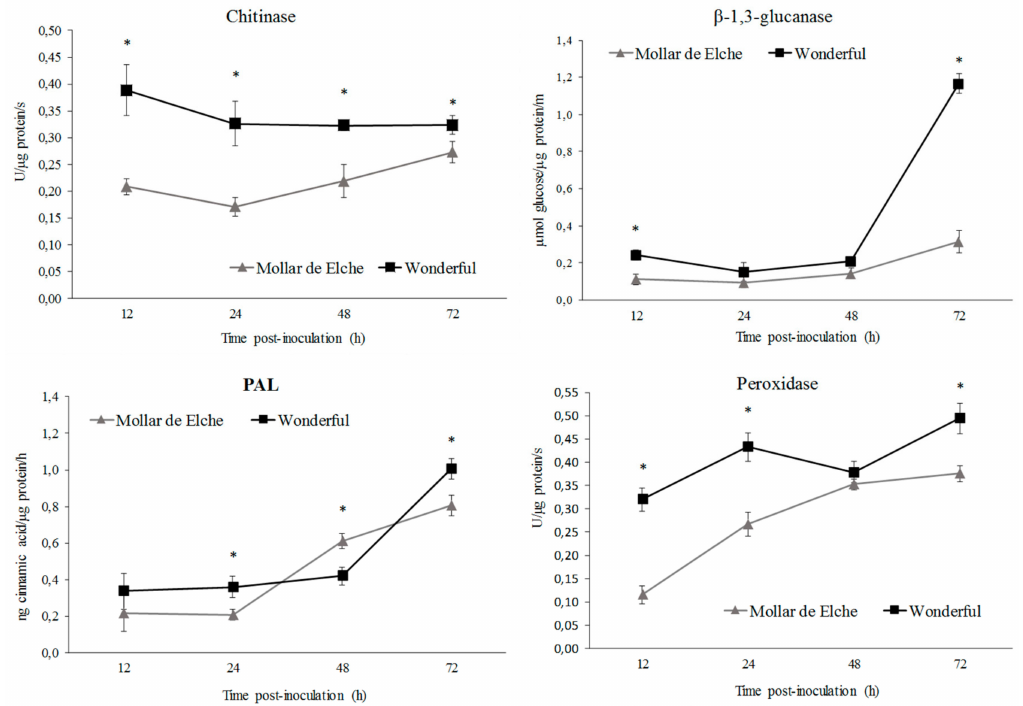
Figure 3. Time course of the activity of the enzymes chitinase, β -1,3-glucanase, PAL, and peroxidase in extracts from ‘Wonderful’ and ‘Mollar de Elche’ rinds inoculated by P. granati . Each unit of measurement is calculated on a total protein basis. Data are the mean of three experiments ± SEM. Time points with an asterisk are statistically di ff erent according to DMRT (* p <